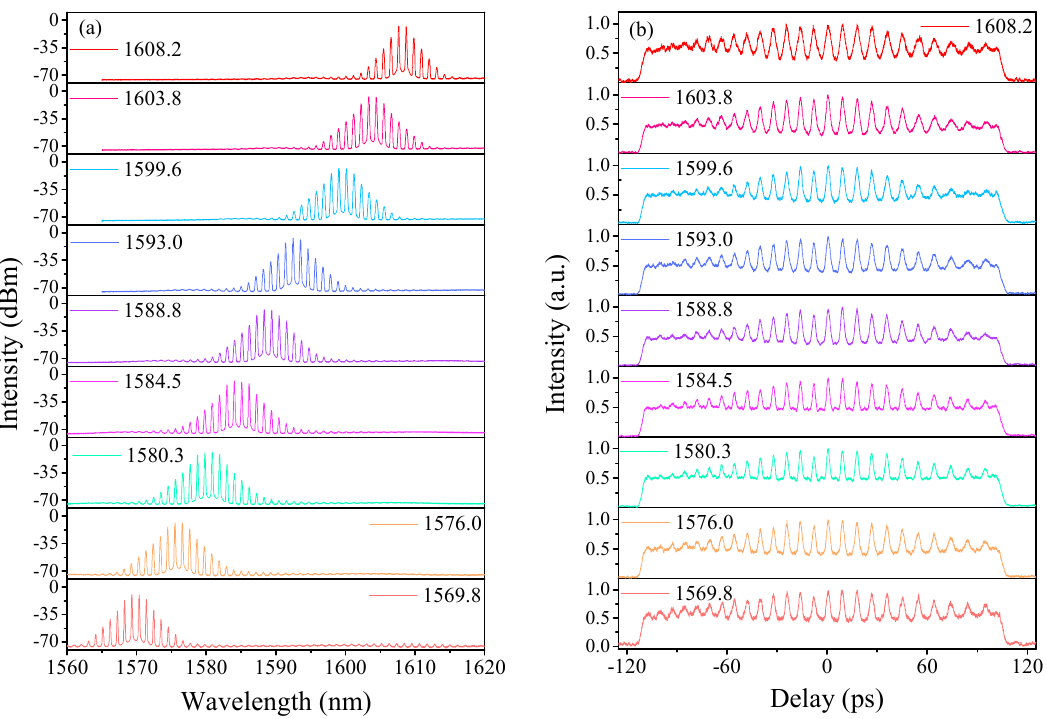
Figure 4. HRR single-soliton train for various orientations of PCs. ( a ) Optical spectra at various central wavelengths. ( b ) Corresponding AC traces.